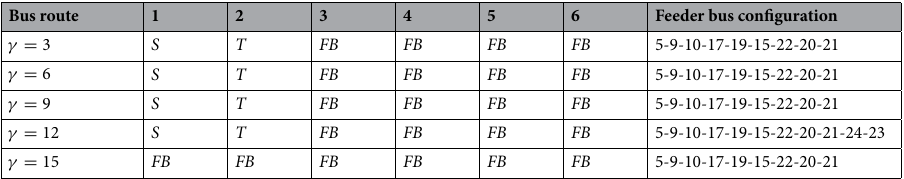
Table 7. Adjustment schemes with different penalties for losing one passenger. Adjustment schemes S , T , and FB represent the stop-skipping strategy, the truncation strategy, and the feeder bus service should be implemented, respectively.